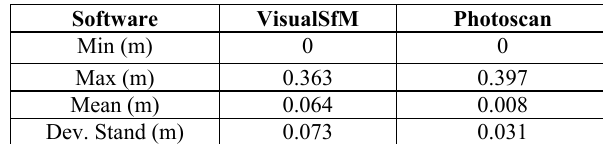
Table 6: Statistical values of the comparisons between the TLS